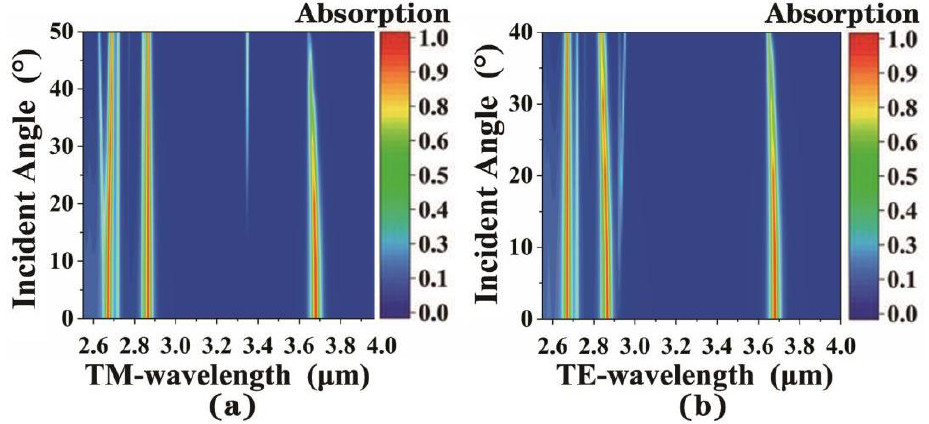
Figure 9. ( a ) Absorption changes of TM polarized waves within an incident angle of 0° – 50° under the premise that other parameters remain unchanged ( b ) Absorption changes of TE polarized waves within an incident angle of 0° – 40° with other parameters fixed.